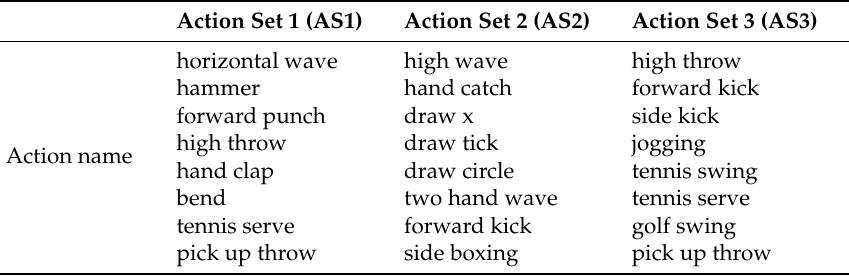
Table 1. MSR-Action3D subset